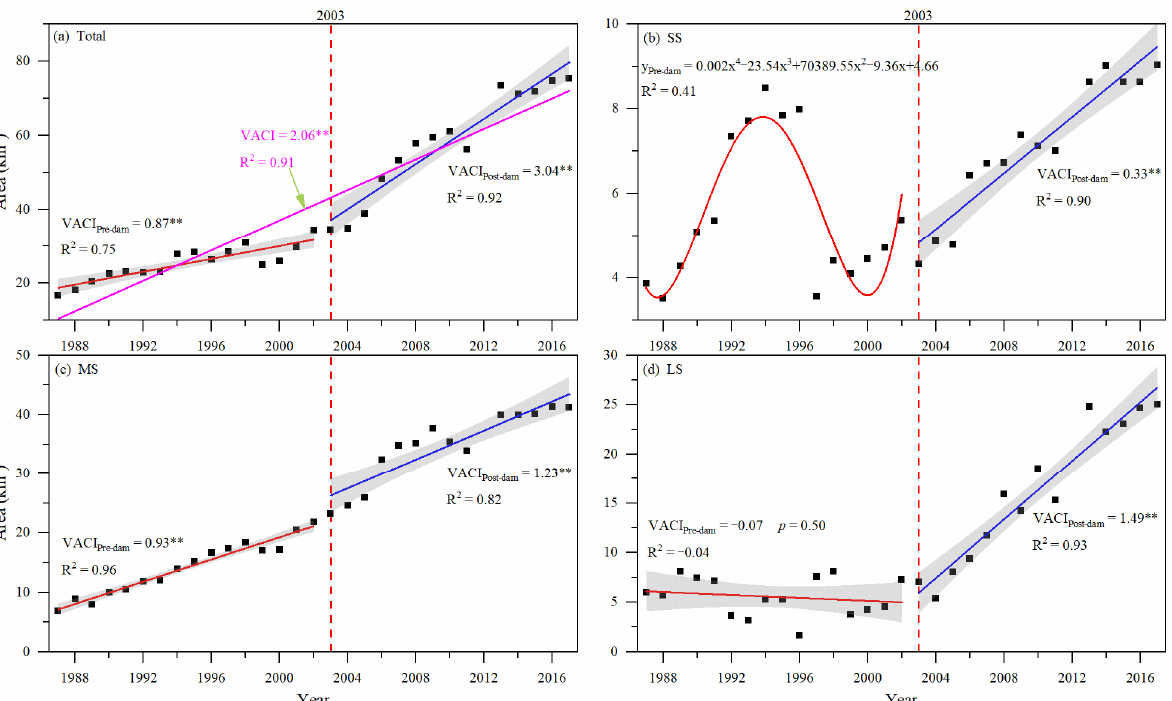
Figure 4. Temporal dynamics of vegetation area in MCBs downstream of the TGD from 1987 to 2017: ( a ) For all of the MCBs, ( b ) for small-sized MCBs (SS), ( c ) for medium-sized MCBs (MS), ( d ) for large-sized MCBs (LS). The parameters VCAI and R 2 represent vegetation area change intensity and coefficient of determination, respectively. Slope values with “**” indicate the F-tested p-value < 0.001. The shaded areas are 95% confidence intervals.